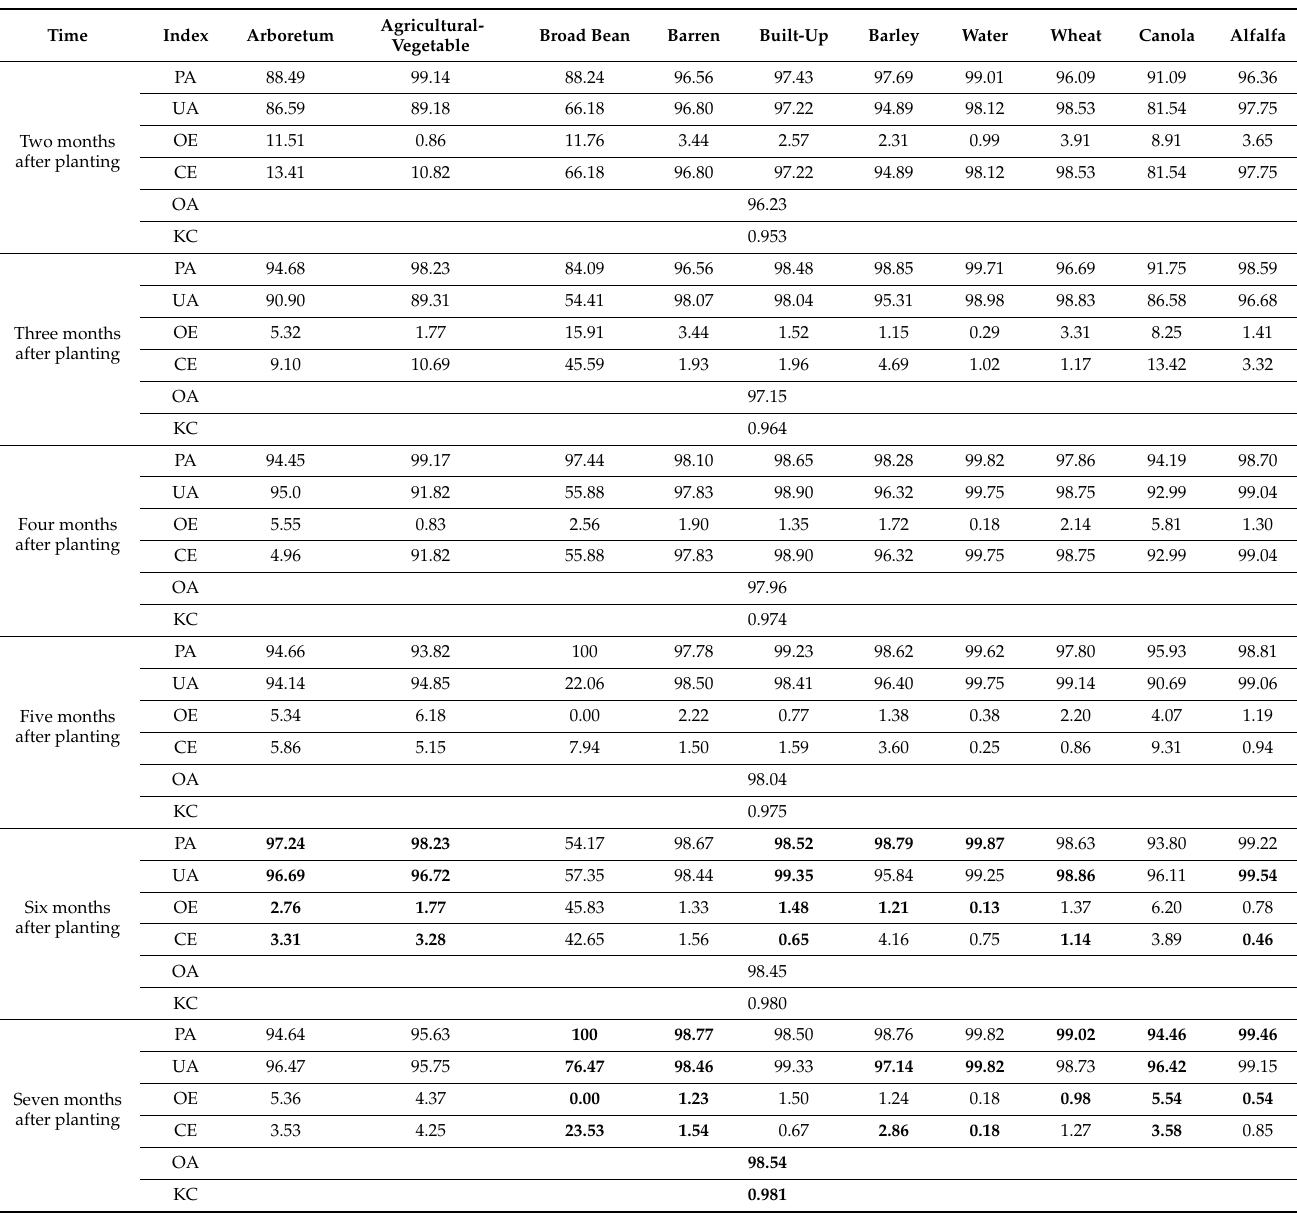
Table 5. The effects of increasing the number of NDVI datasets on the classification accuracies obtained using the proposed method. The bold values show the highest accuracies (OA: overall accuracy, KC: kappa coefficient, UA: user accuracy, PA: producer accuracy, OE: omission error, CE: commission